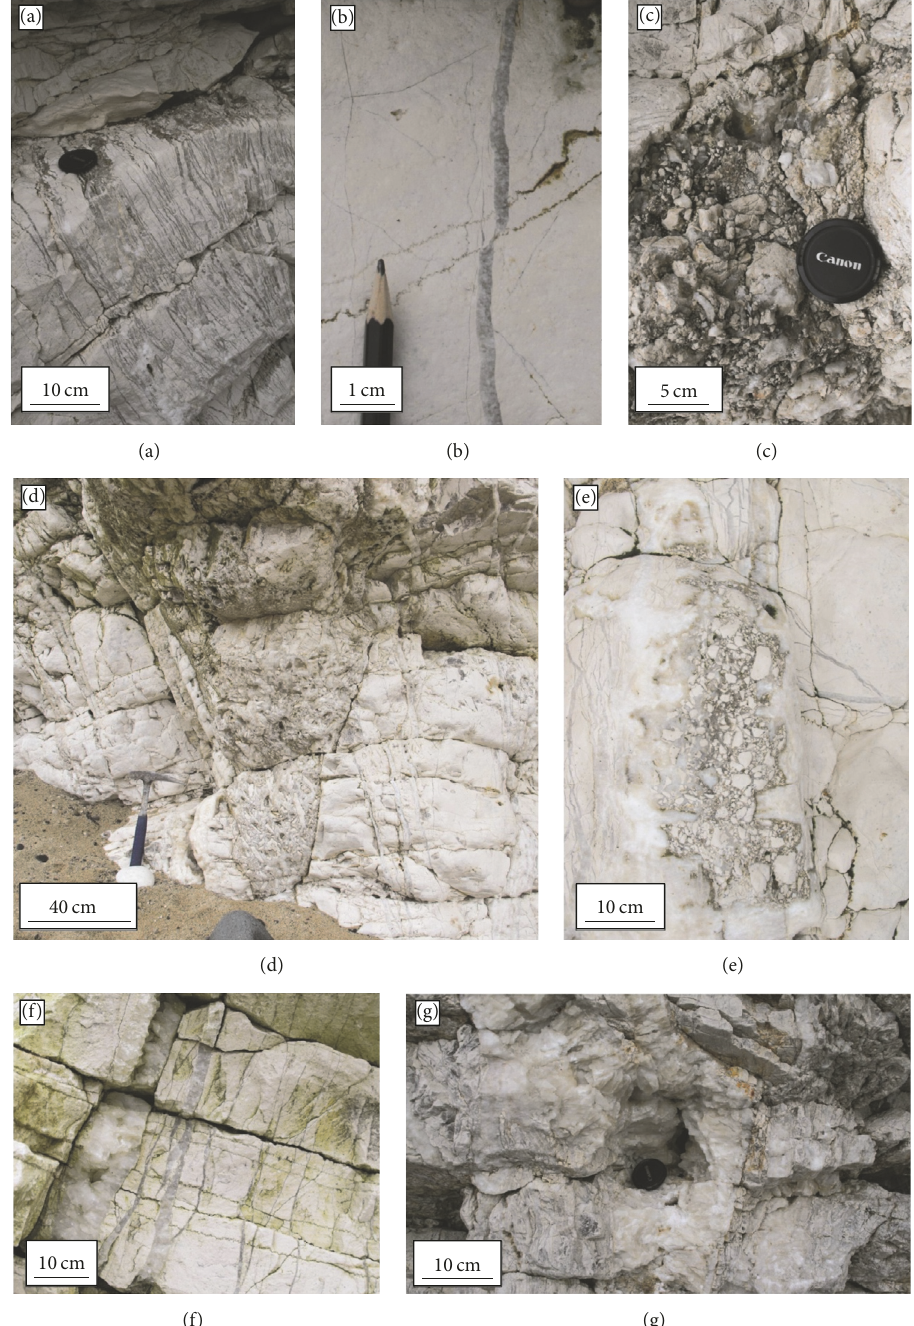
Figure 2: Macroscopic observations of the calcite veins. (a) Group I vein generation characterized by a network of pseudo parallel thin veins. (b) A vein from Group I crosscut and displaced by a compaction stylolite. (c) Hydraulic breccia and its typical jigsaw texture. (d) Hydraulic breccia crosscutting the stratigraphic section and compaction stylolites. (e) Hydraulic breccia (with Group II veins) intruded by Group III vein (bright white color). (f) Group III vein crosscutting compactional stylolites. (g) Large calcite crystals infilling porosity along the main fault plane (Group III